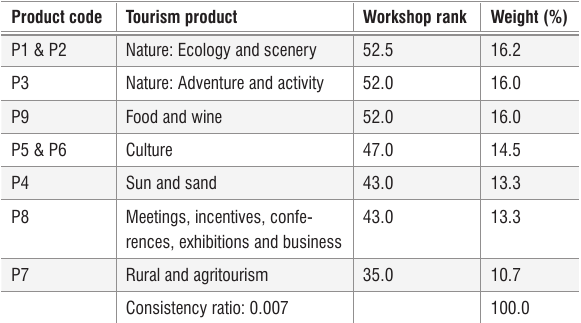
Table 2 : Spatial factor weights for the calculation of all products’ potential Product code Tourism product